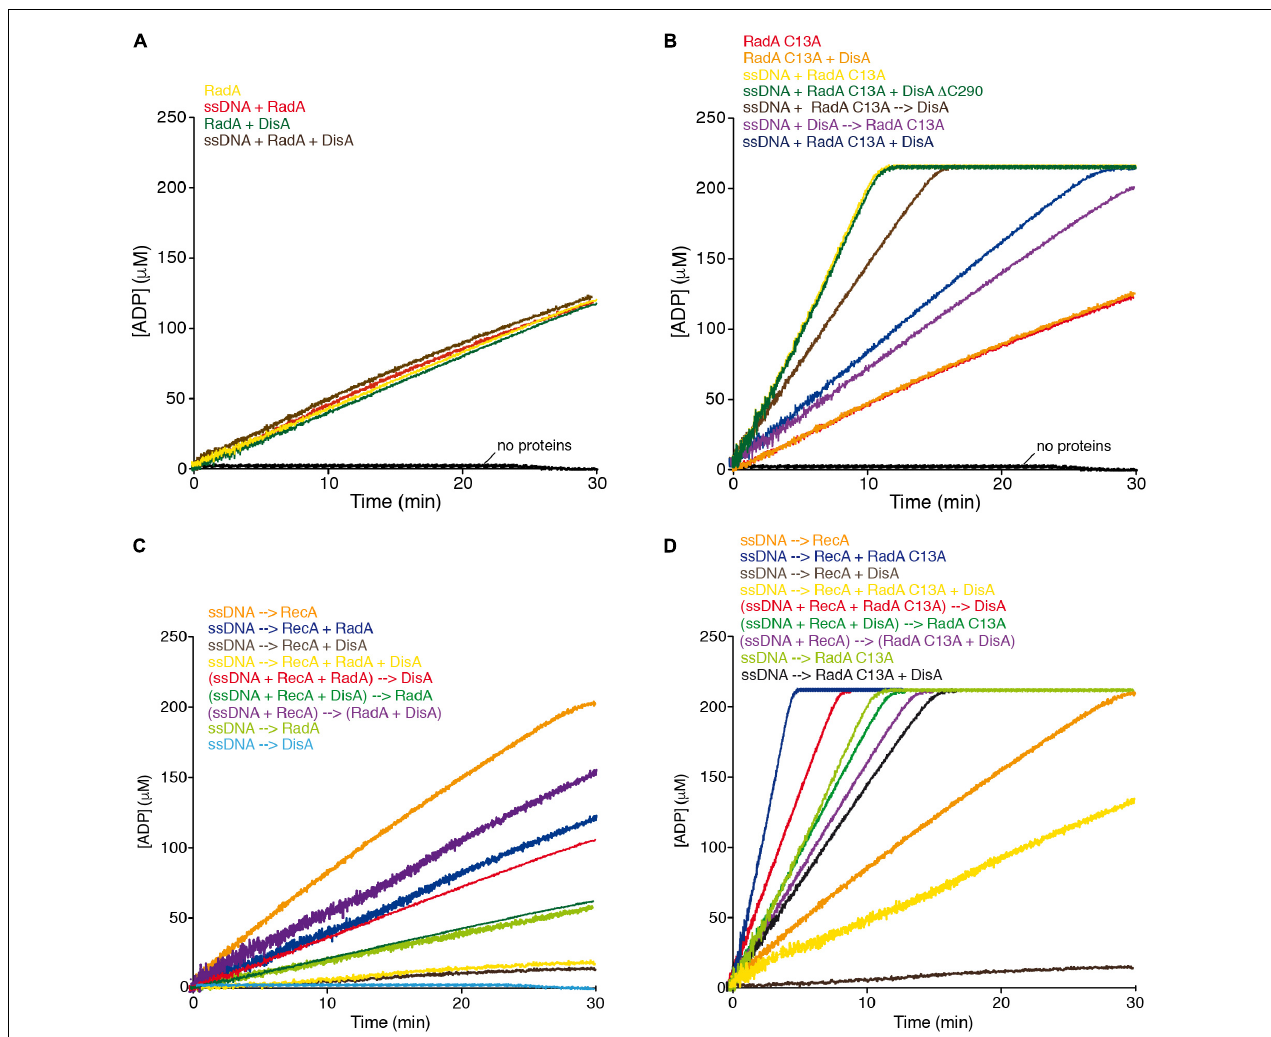
FIGURE 2 | DisA inhibits RadA/Sms ATPase activity, and with RadA/Sms competitively reduce RecA-mediated ATP hydrolysis. (A) RadA/Sms-mediated ATP hydrolysis in the presence of DisA. Reactions had RadA/Sms (400 nM), DisA (500 nM), and when indicated cssDNA (10 µ M in nt) in buffer A. (B) cssDNA was incubated with RadA/Sms C13A (400 nM) and DisA or DisA (cid:49) C290 (500 nM), or cssDNA was pre-incubated with RadA/Sms C13A or DisA (5 min at 37 ◦ C), and then DisA or RadA/Sms C13A were added in buffer A. (C) cssDNA was incubated with RecA (800 nM), RadA/Sms (200 nM) or DisA (100 nM) or with RecA, RadA/Sms and DisA, or with RecA and RadA/Sms, or with RecA and DisA; or cssDNA was preincubated with RecA, or RecA and RadA/Sms or RecA and DisA (5 min at 37 ◦ C), then RadA/Sms, DisA or both were added in buffer A. (D) cssDNA was incubated with RecA (800 nM), RadA/Sms C13A (200 nM) or DisA (200 nM), or with RecA, RadA/Sms C13A and DisA, or with RecA and RadA/Sms C13A, or with RecA and DisA, or with RadA/Sms C13A and DisA; or cssDNA was pre-incubated with RecA, or with RecA and RadA/Sms C13A, or with RecA and DisA (5 min at 37 ◦ C), and then DisA, RadA/Sms C13A or both were added in buffer A. Buffer A contains the ATP regeneration system. Reactions were started by addition of ATP (5 mM), and the ATPase activity was measured (30 min at 37 ◦ C). All reactions were repeated three or more times with similar results. A representative graph is shown here, and quantifications of ATP hydrolyzed are shown in the main text as the mean ± SD of > 3 independent